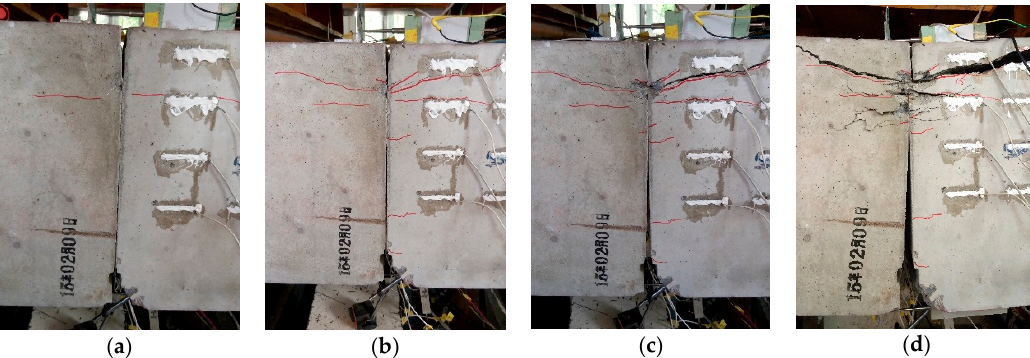
Figure 15. Type-A joint under a negative bending moment: ( a ) core section cracking; ( b ) quickly developing cracks; ( c ) crack penetration; ( d ) concrete crushing.